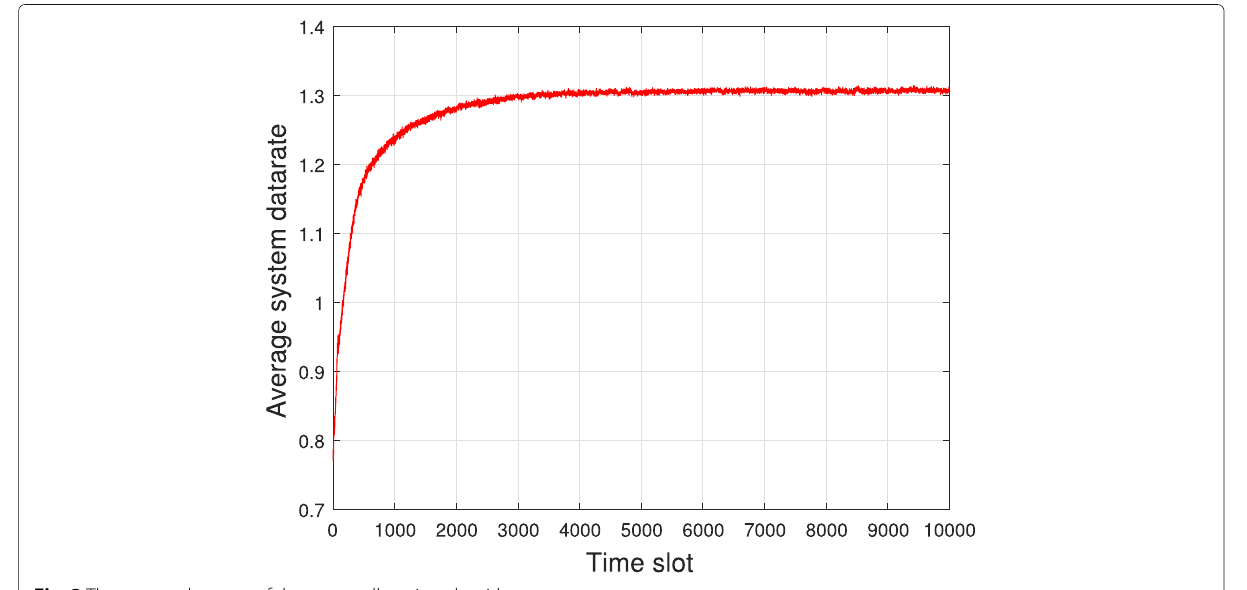
Fig. 3 The system data rate of the power allocation algorithm